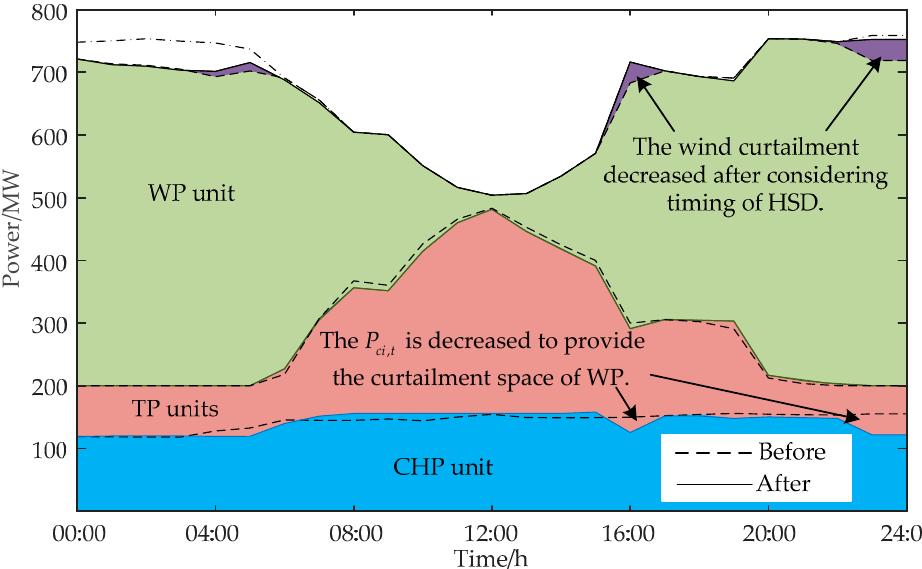
Figure 11. The output of each unit before and after considering the temporal dependence of wind power fluctuation.